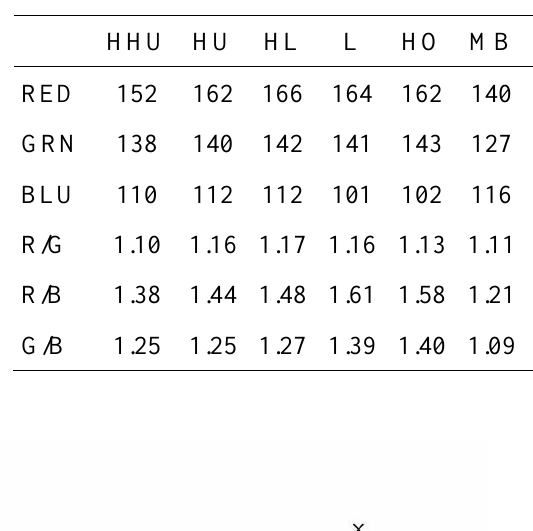
Table 5. Mean image DN values at nadir and the corresponding band ratios .